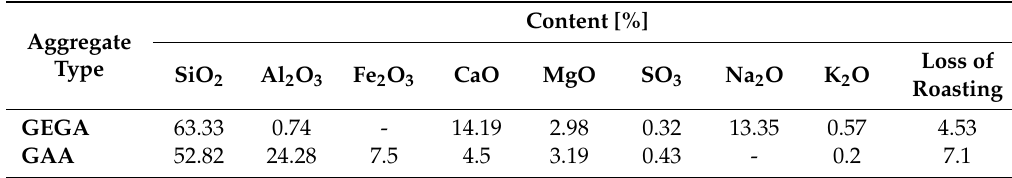
Table 2. The chemical composition of the aggregate [15].